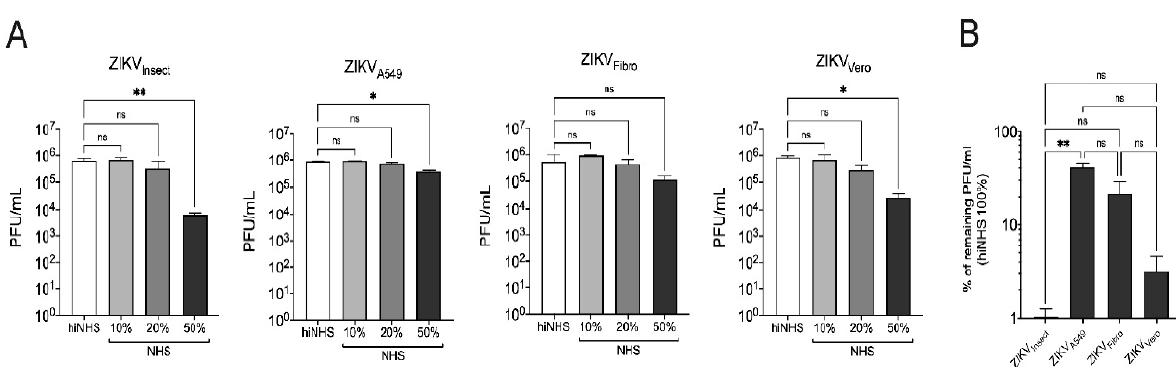
Figure 1. Serum stability of Zika virus (ZIKV) is affected by cell-line-dependent features. ( A ) ZIKV Insect , ZIKV A549 , ZIKV Fibro, and ZIKV Vero were incubated with increasing amounts of active or heat-inactivated human serum. ( B ) For analysis of the different viral preparations, the input virus was normalized on the amount of virus in heat-inactivated normal human serum (hiNHS). The graph shows the stability of ZIKV derived from different cells in 50%NHS. In both sets of experiments, virus-serum mixtures were incubated for 1 h at 37 ◦ C, then diluted 10-fold, titrated on 12-well plates of overnight-plated Vero cells and incubated for 1 h before plaque agarose was overlaid. Plaques were visualized four days post infection using crystal violet staining. All assays were performed in triplicate, and the error bars show standard deviations. A 95% significance level ( p < 0.05) was considered statistically significant (* < 0.05, ** <